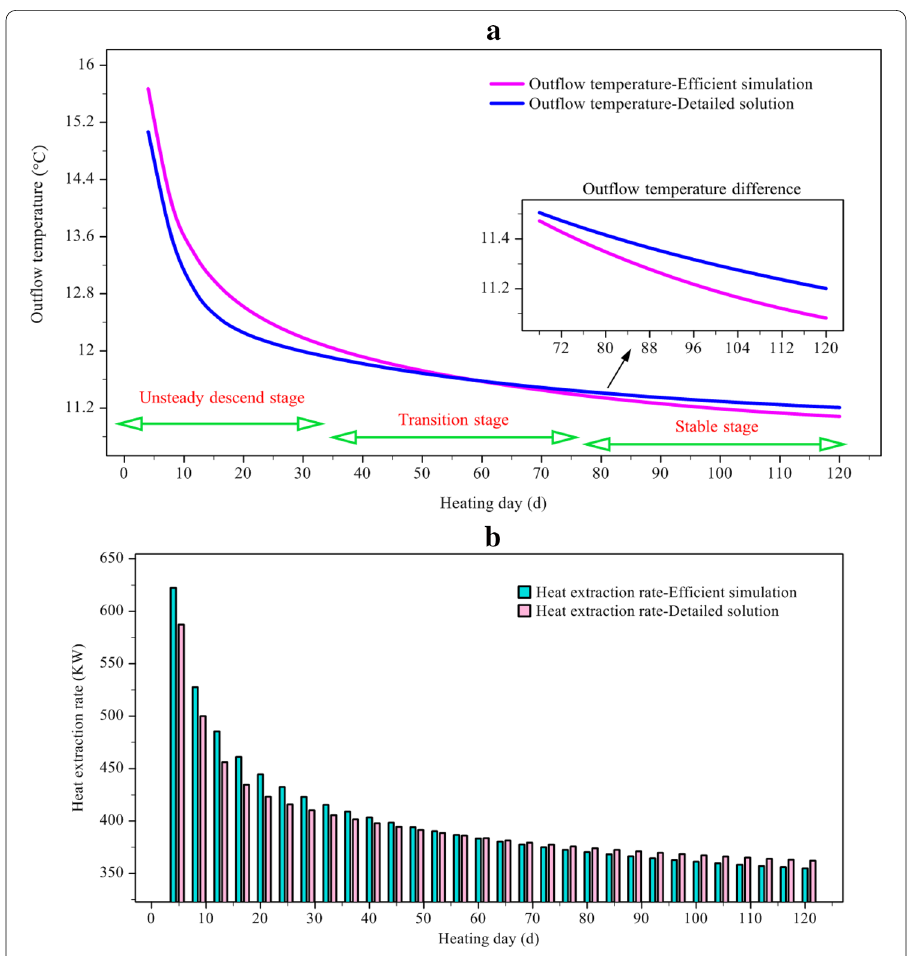
Fig. 9 Dynamic evolution process of heat extraction rate and outlet temperature with time during the heating season: a Outflow temperature. b Heat extraction